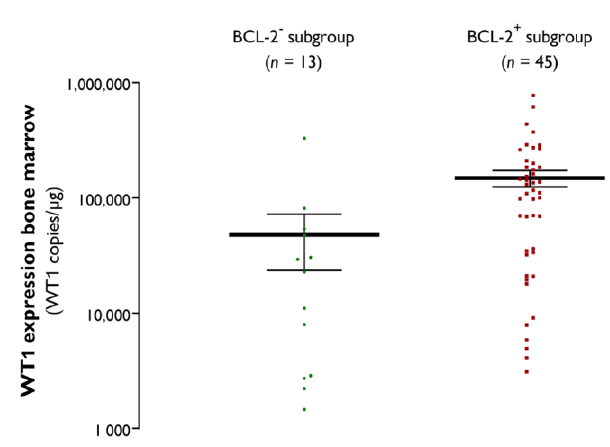
Figure 2. Bone marrow WT1 transcript levels in the BCL-2 − and BCL-2 + AML subgroups, with the black horizontal lines indicating the mean ± SEM values (copies/µg).